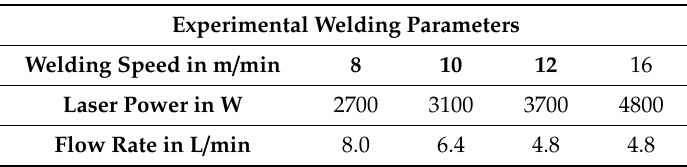
Figure 4. Loss of mass depending on flow rate and process characteristics for: ( a – d ) Reference process; ( e – h ) Gas-assisted process. Table 3. Defect-free welding parameters at lowest loss of